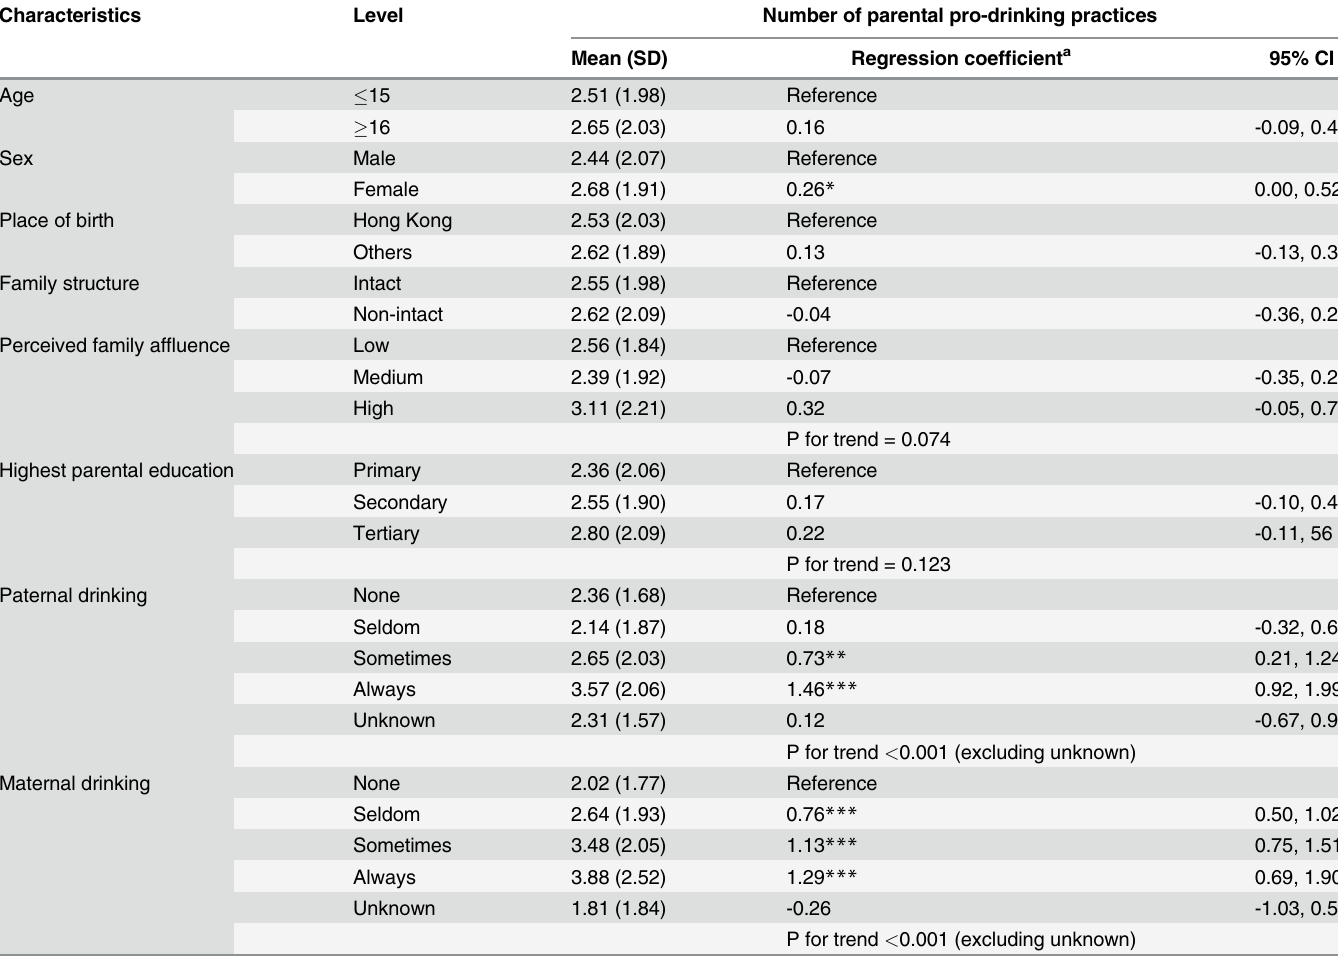
Table 6. Mean (SD) and regression coef fi cient on the number of parental pro-drinking practices.